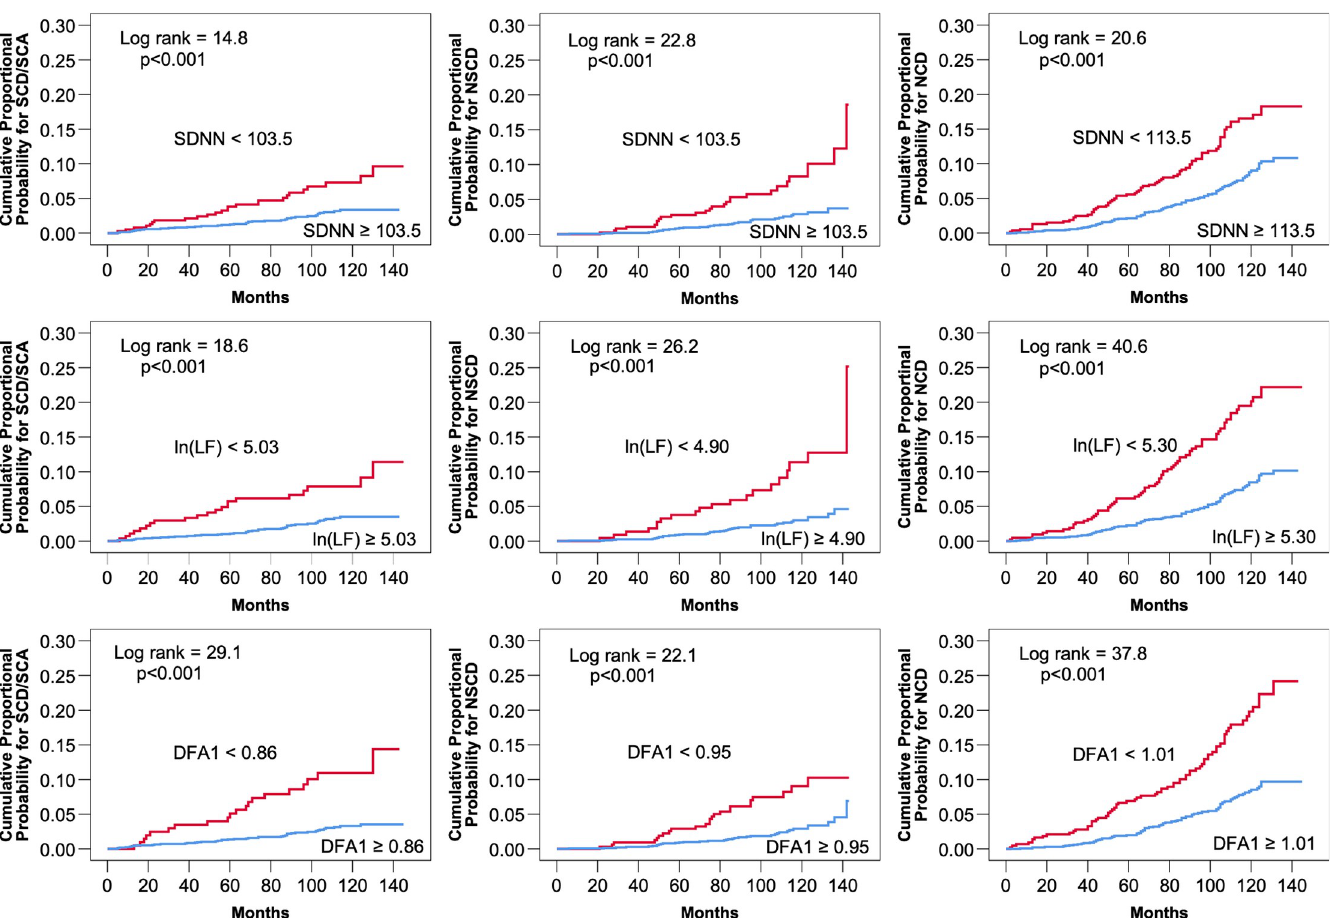
Fig 1. Cumulative proportional probabilities for sudden cardiac death or sudden cardiac arrest (SCD/SCA), non-sudden cardiac death (NSCD), and non-cardiac death (NCD).